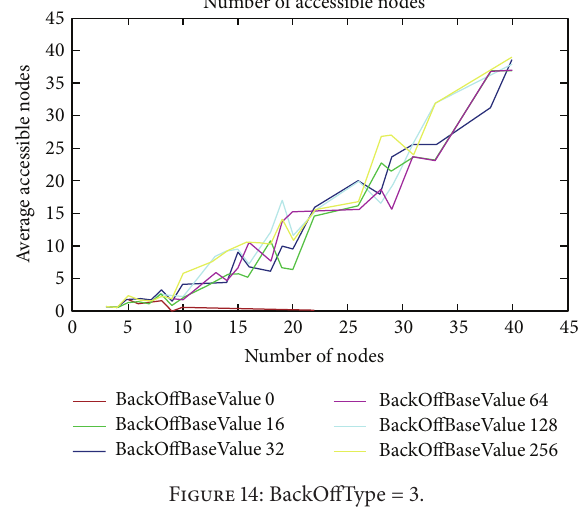
Figure 17: Image in the mobile when there is a request to one